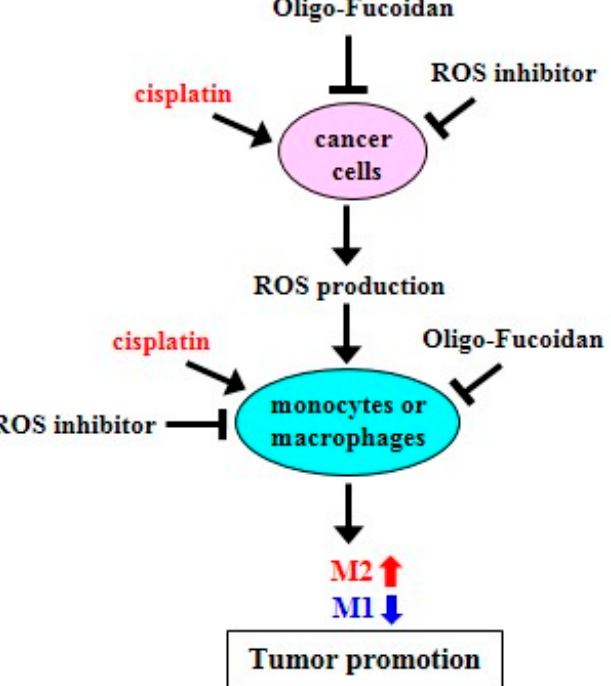
Figure 9. Schematic summary of Oligo-Fucoidan, ROS inhibitor and cisplatin effect on macrophage polarization and cancer treatment. Cisplatin induces ROS production but ROS inhibitor and Oligo-Fucoidan suppress ROS generation in aggressive cancer cells, which indirectly change macrophage polarity. Direct inhibition of ROS generation in monocytes or M2 macrophages by ROS inhibitor and Oligo-Fucoidan could synergistically promote M1 phenotype and prevent M2 polarity. Thereby, an antioxidant mechanism potentially establishes the tumor suppressive microenvironment(s) that prevent tumor progression.